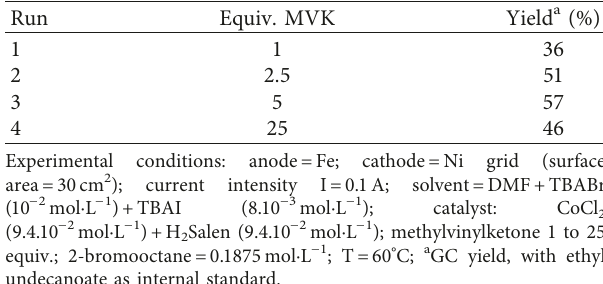
Table 3: Stoichiometric study of the reaction between MVK and 2- bromooctane. Run